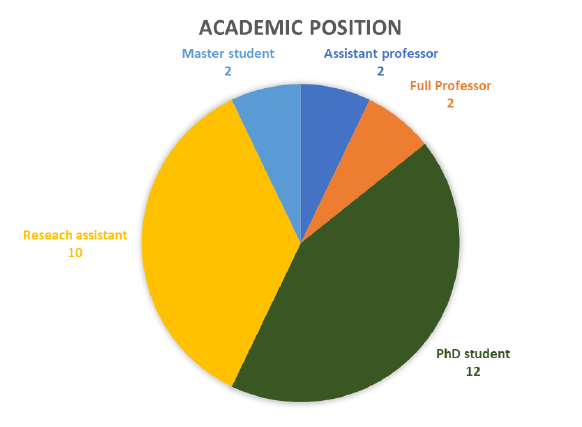
Figure 5 . Academic position of the applicants.